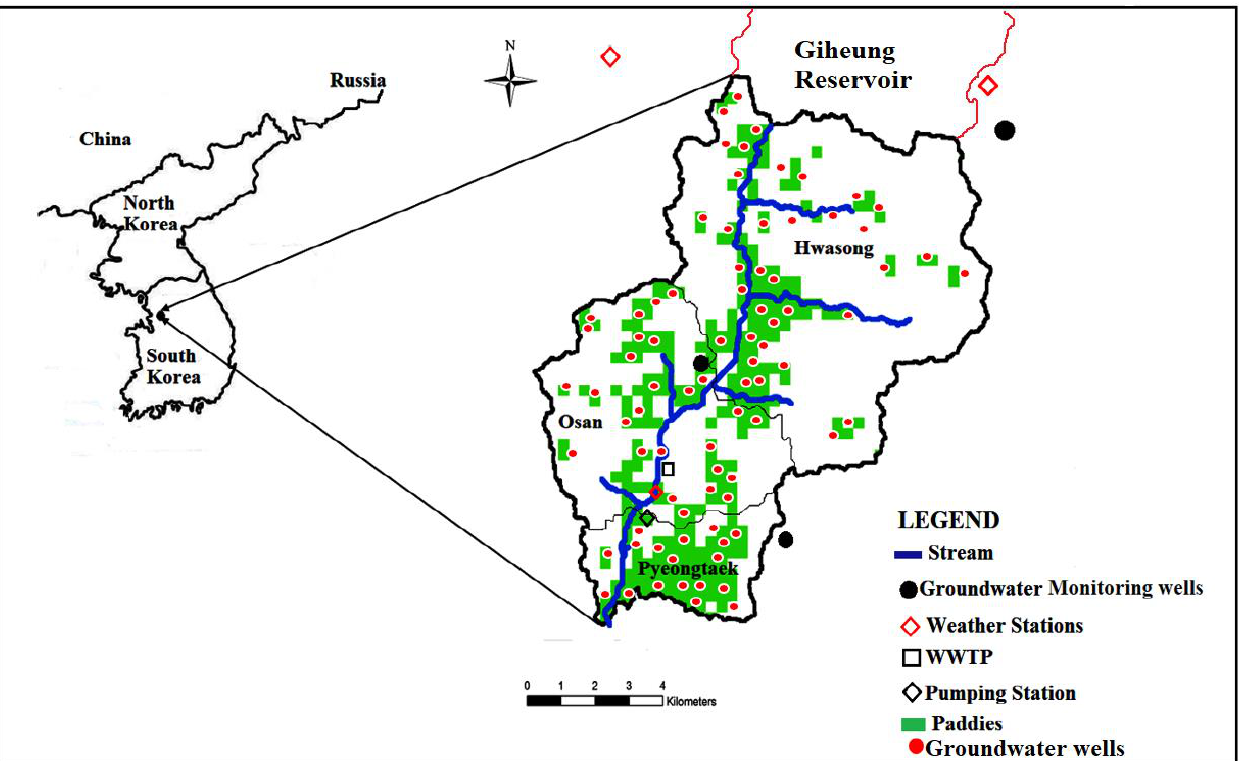
Figure 1. Osan watershed showing the Osan stream and meteorological stations. Meteorological data pertaining to the monthly rainfall and average monthly tempera- ture were collected from the Korean Meteorological Administration (https://data.kma.go.kr/ data/grnd/selectAsosRltmList.do?pgmNo=36/ accessed on 8 March 2021). Yearly agricul- tural groundwater extraction and yearly agricultural surface water supply data were obtained from the Water Resource Management Information System (http://www.wamis.go.kr/